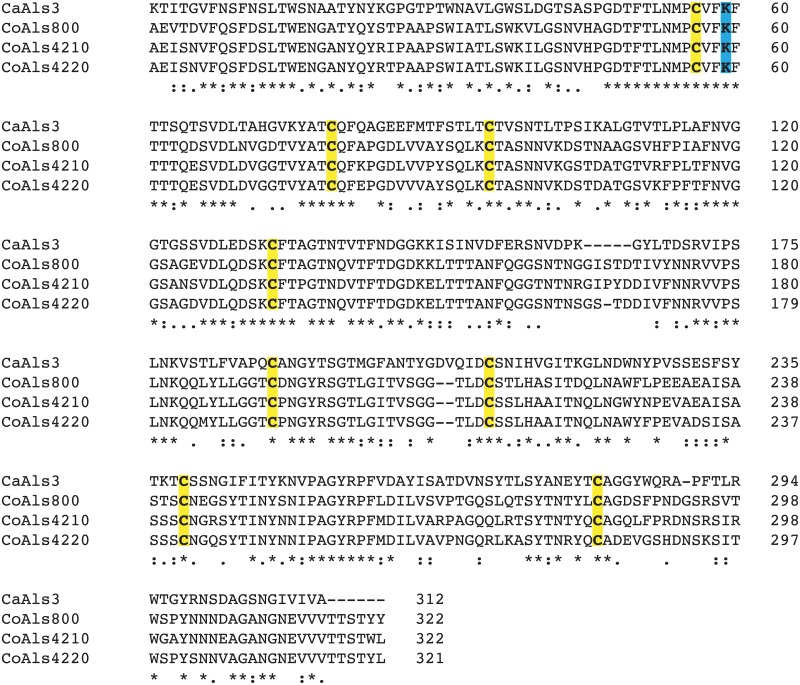
Conserved NT-Als features suggested adhesive activity for CoAls proteins.The mature (signal peptide removed) NT domains of CoAls800, CoAls4210, and CoAls4220 contained 8 Cys residues in conserved positions (highlighted in yellow), which are essential for the folding of C. albicans (Ca) NT-Als3 for which the three-dimensional structure was solved [7]. Conservation of NT-Als3 adhesive function in the CoAls proteins was also suggested by the presence of the invariant Lys (K59) located in the CaNT-Als3 binding cavity (highlighted in blue). The amino acid alignment was produced using Clustal Omega (https://www.ebi.ac.uk/Tools/msa/clustalo). Identical (*), conserved (:), and semi-conserved (.) amino acids are indicated below the alignment. Dashes in the sequence indicate gaps. The sequence of C. albicans Als3 (CaAls3; GenBank accession number AY223552) was used as a reference.